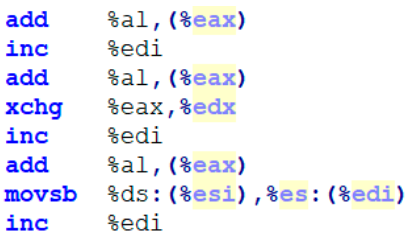
Figure 9. ASM file.